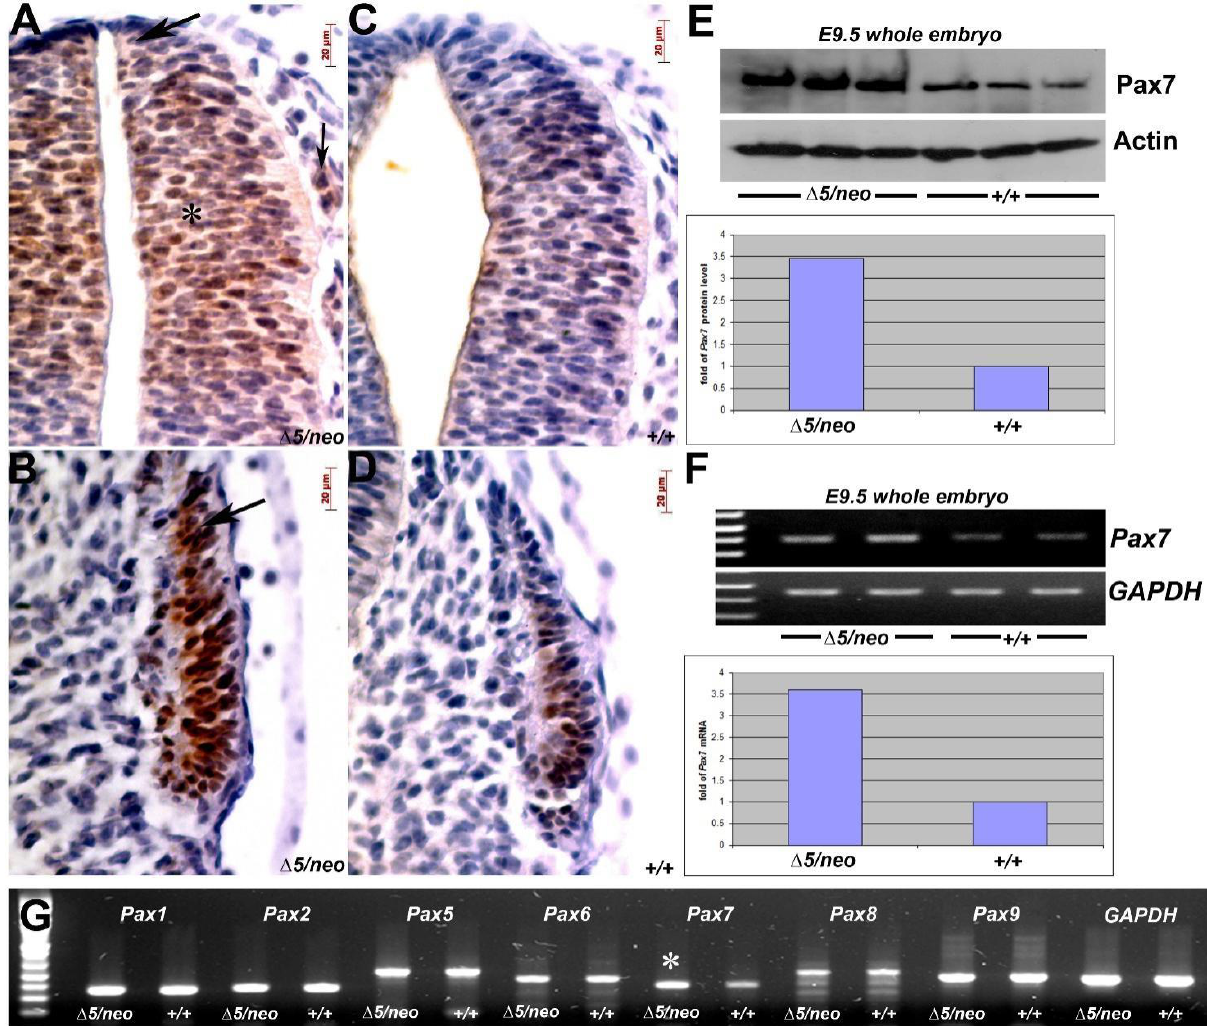
Figure 3. Reduced Pax3 in Pax3 ∆ 5/neo mutants elicits ectopic and elevated Pax7 expression. ( A – D ) Pax7 IHC in E10.5 Pax3 ∆ 5/neo and wildtype embryos revealed that Pax7 expression is both upregulated (indicated by bold arrow in A ) and dorsally expanded (indicated by * in A ) into the most dorsal region that is usually devoid of Pax7 with the Pax3 ∆ 5/neo neural tube ( A ) compared to wildtype littermate ( C ). Additionally, ectopic Pax7 is also observed in migrating Pax3 ∆ 5/neo neural crest cells adjacent to the dorsal neural tube (small arrow in A ) but not wildtype ( C ). Furthermore, Pax7 is upregulated and dorso-laterally expanded in the Pax3 ∆ 5/neo somites (arrow in B ) compared to wildtype ( D ). ( E ) Western blot verification of Pax7 upregulation in Pax3 ∆ 5/neo whole embryo lysate at E9.5. Three individuals for each genotype were analyzed and densitometry reveals a ~3.4 fold increase in Pax7 protein compared to Actin levels. ( F ) RT-PCR analysis of Pax7 mRNA levels in duplicate wildtype and Pax3 ∆ 5/neo E9.5 in whole embryos. Densitometry confirms a ~3.5x fold increase in Pax7 compared to GAPDH levels in Pax3 ∆ 5/neo mutants. ( G ) Comparative RT-PCR analysis of Pax gene family in Pax3 ∆ 5/neo mutants. Note, only Pax7 mRNA was elevated (indicated by *) in Pax3 ∆ 5/neo embryos when Pax3 is reduced, as Pax1, 2, 5, 6, 8 and 9 mRNA levels were similar to wildtype when normalized to GAPDH levels. Note Pax4 mRNA is restricted to the pancreas and was not detectable in both geno- types (not shown) under the given conditions. Scale ( A – D ), 20 μm. 3.3. Pax7 Plays a Functional Genetic Compensation Role in Heart and Neural Tube Development The observations that Pax3 neo/ Δ 5 mutants do not exhibit any of the typical Pax3 -deficent cardiovascular defects and that Pax7 ectopic expression is a specific response to 90% Pax3 reduction in Pax3 neo/∆5 prompted us to test the biological significance of this augmented Pax7 expression. To achieve this goal, we generated Pax3 neo/∆5 embryos bearing either one